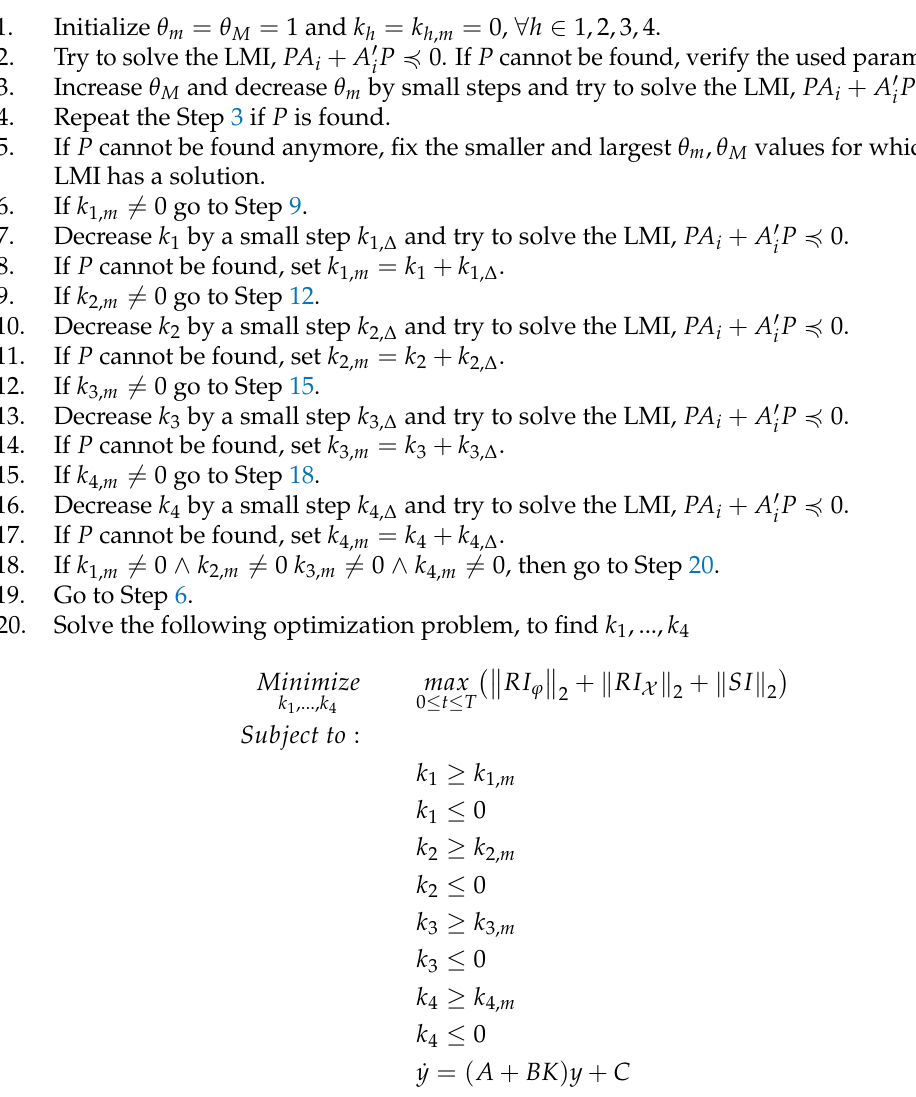
Algorithm 1 An algorithm is presented to numerically find appropriate values for P , θ m , θ M